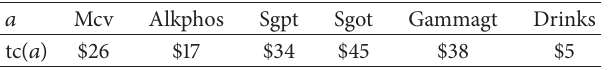
Table 3: An example of test cost